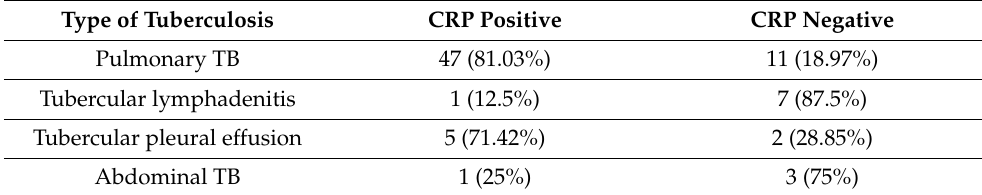
Table 9. Ideal C-Reactive Protein value ( ≥ 8.25) and types of TB.